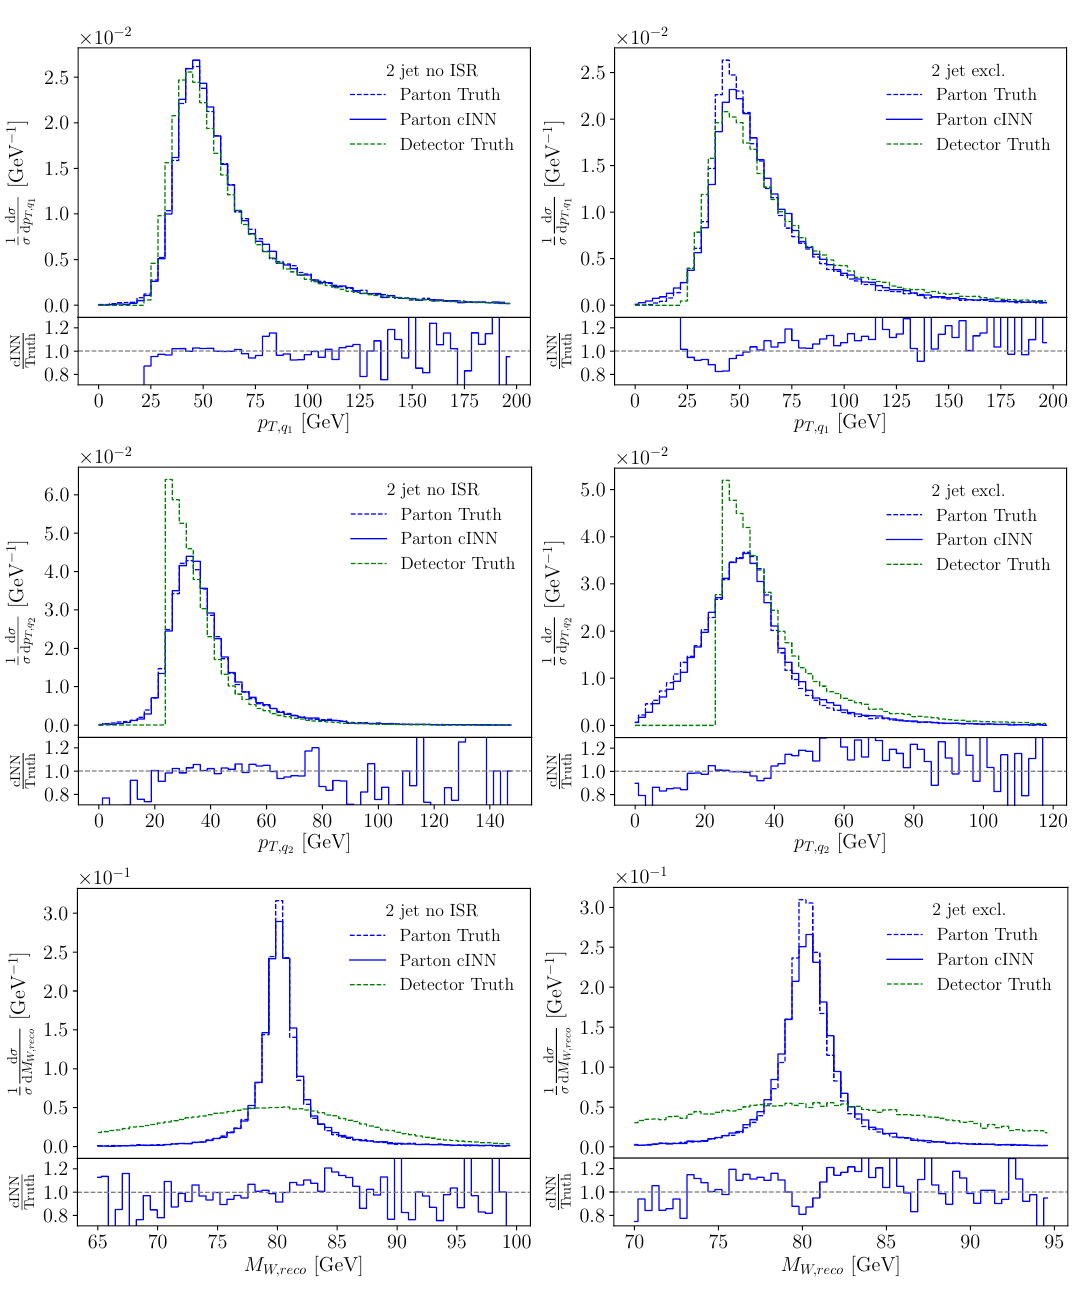
Figure 6: cINNed p and m distributions. Training and testing events include T , q W ,reco exactly two jets. In the left panels we use a data set without ISR, while in the right panels we use the two-jet events in the full data set with ISR. The lower panels give the ratio of cINNed to parton-level